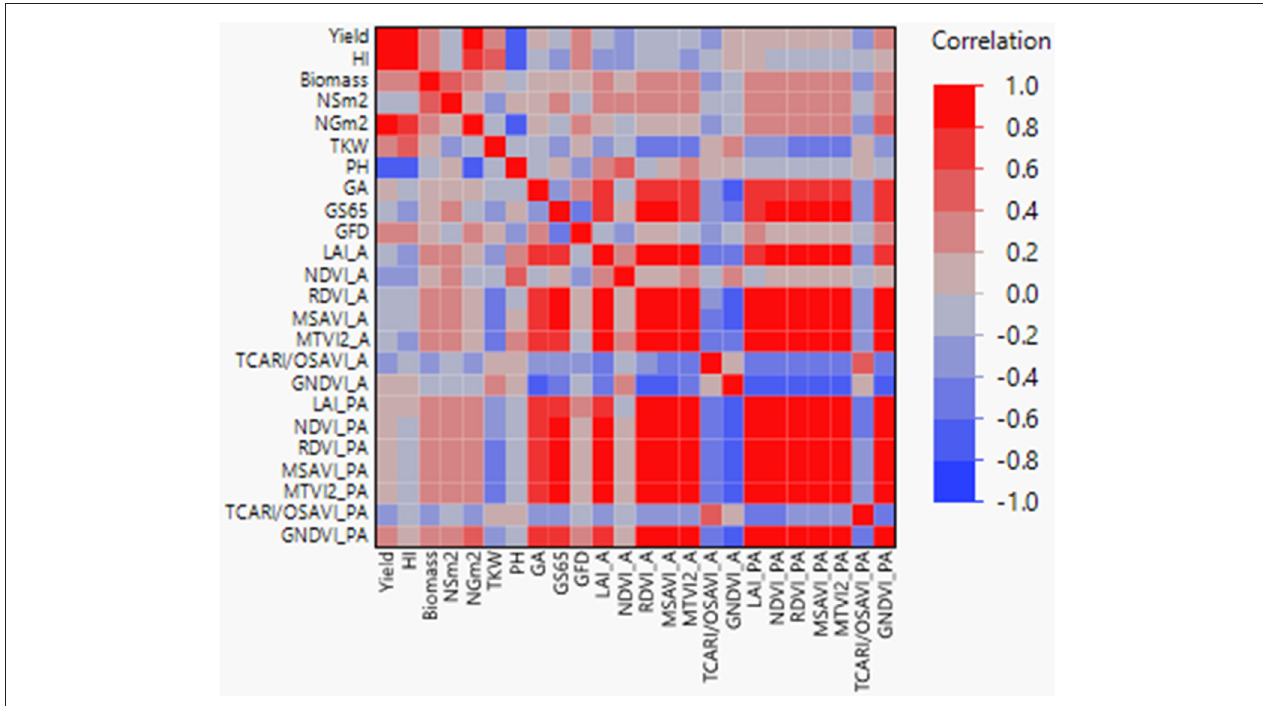
FIGURE 2 | Pearson correlations between agronomic traits, vegetation indices (VIs), and LAI + . GS65, number of days from sowing to A. GFD, grain filling duration; HI, harvest index; NSm2, number of spikes per square meter; NGm2, number of grains per square meter; TKW, thousand kernel weight; LAI, leaf area index; PH, plant height; GA, green area; A, anthesis; PA, postanthesis. Significant correlations at P < 0.0001 were established for r > 0.45 and r < −